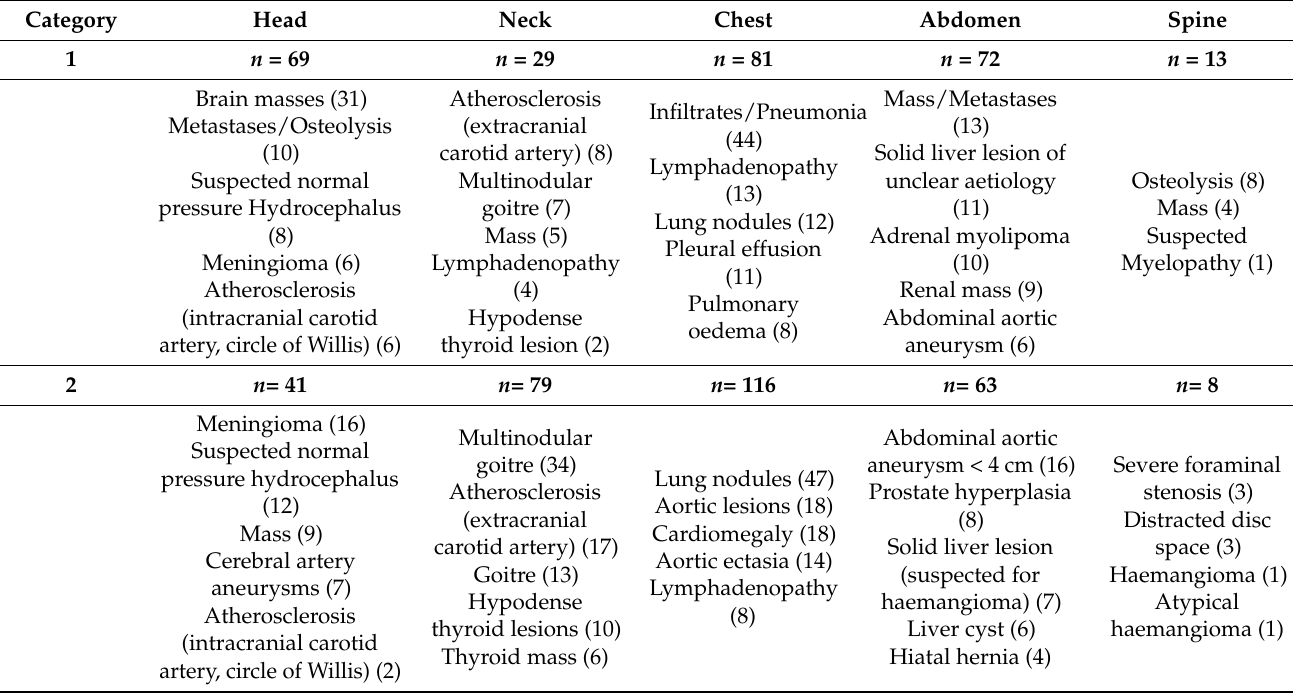
Table 5. Top 5 incidental findings per region categorised 1 and